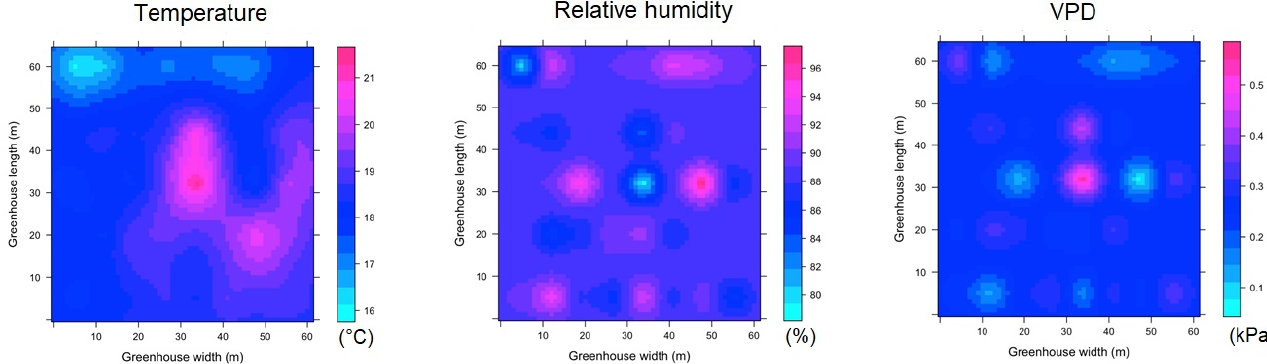
Figure A6. Spatial distribution predicted by kriging, for temperature, relative humidity and VPD in TG and for ESRL 4.